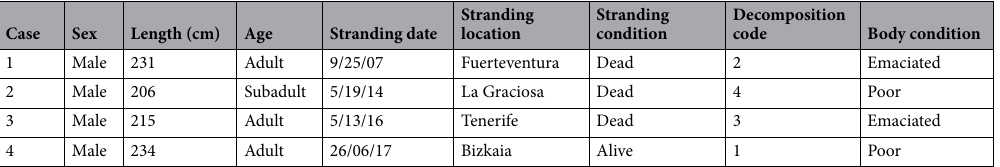
Table 1. Biologic and epidemiologic data of striped dolphins included in this study.